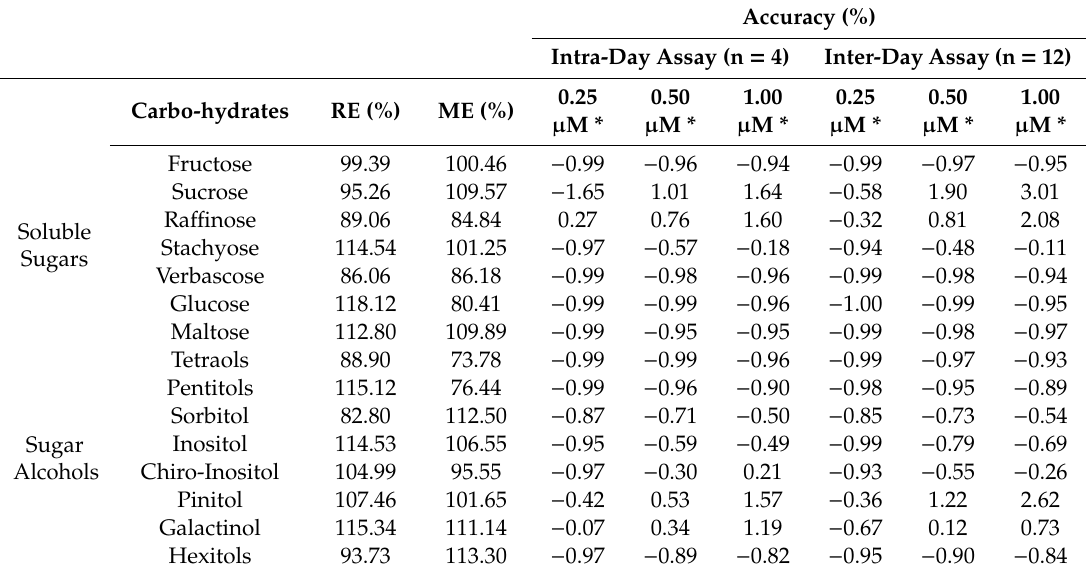
Table 2. Recovery (%), matrix e ff ect (%), intra- and interday accuracy (%) of the soluble sugars and sugar